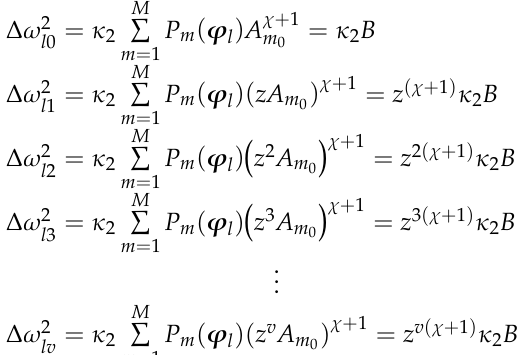
Figure 6. Experimental configuration.